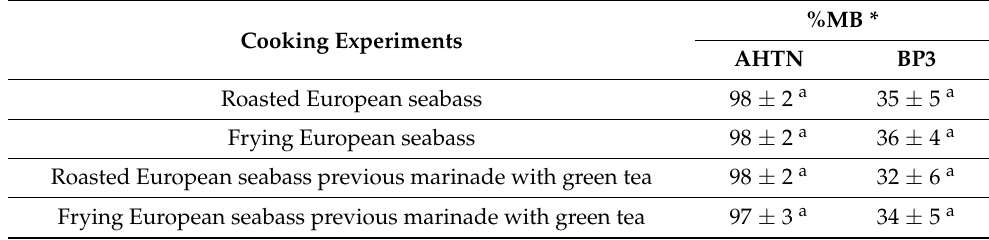
Table 1. Percentages (%MB) of the in vitro digestion experiment (mean ± standard deviation; n = 3). Cooking Experiments